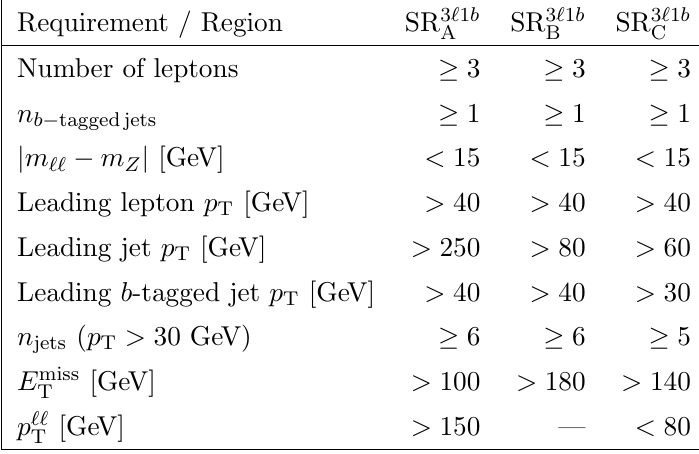
Table 2. De(cid:12)nition of the signal regions used in the 3 ‘ 1 b selection (see text for